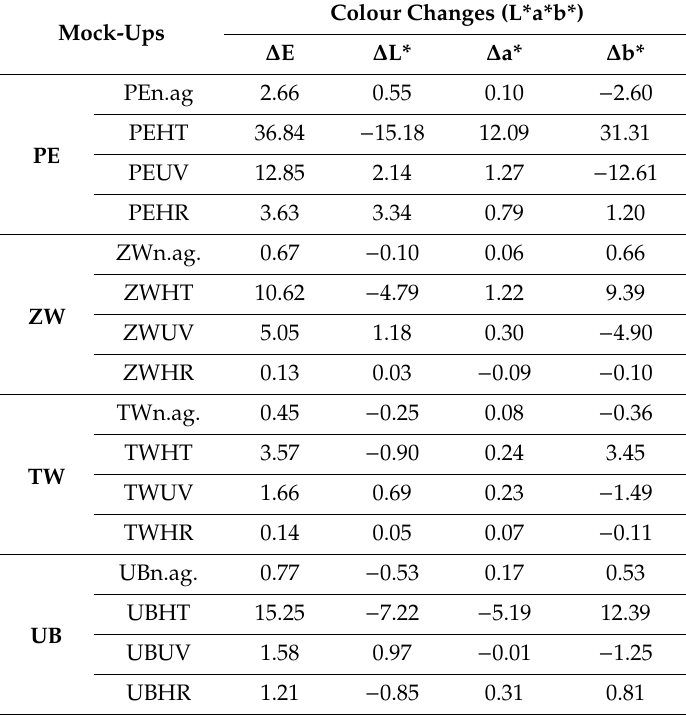
Table 4. Colour changes calculated as ∆ E, ∆ L*, ∆ a* and ∆ b* after natural and accelerated ageing. Colour Changes (L*a*b*) Mock-Ups ∆ E ∆ L* ∆ a* ∆ b* PEn.ag PE